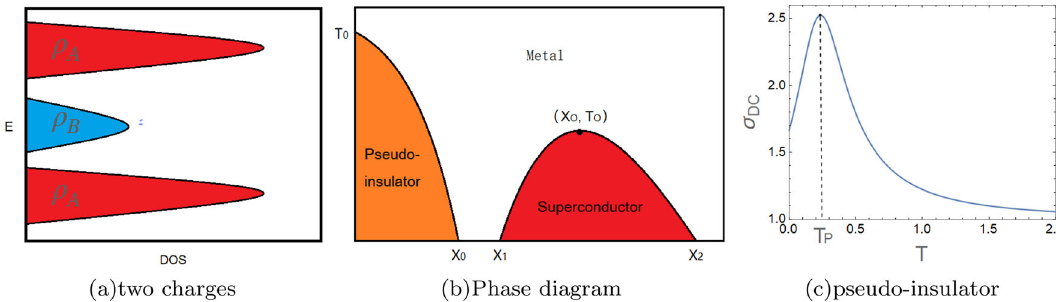
Fig. 1 a ThedensityofthestatesfordopedMottinsulator.Thedegrees of freedom in the red region are provided by non-moving charge with density ρ A , while those of the blue region is provided by the doped charges ρ N . b Phase diagram in the temperature-doping plane. The line connecting ( x 0 , 0 ),( 0 , T 0 ) denotes the phase boundary of the pseudo-